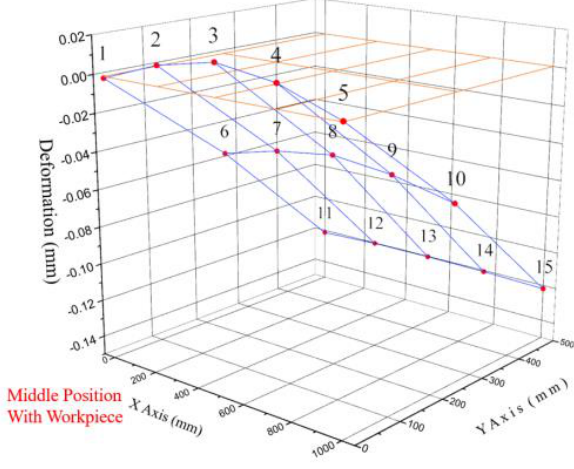
Figure 11. Schematic diagram of the load at the midpoint of the spindle.